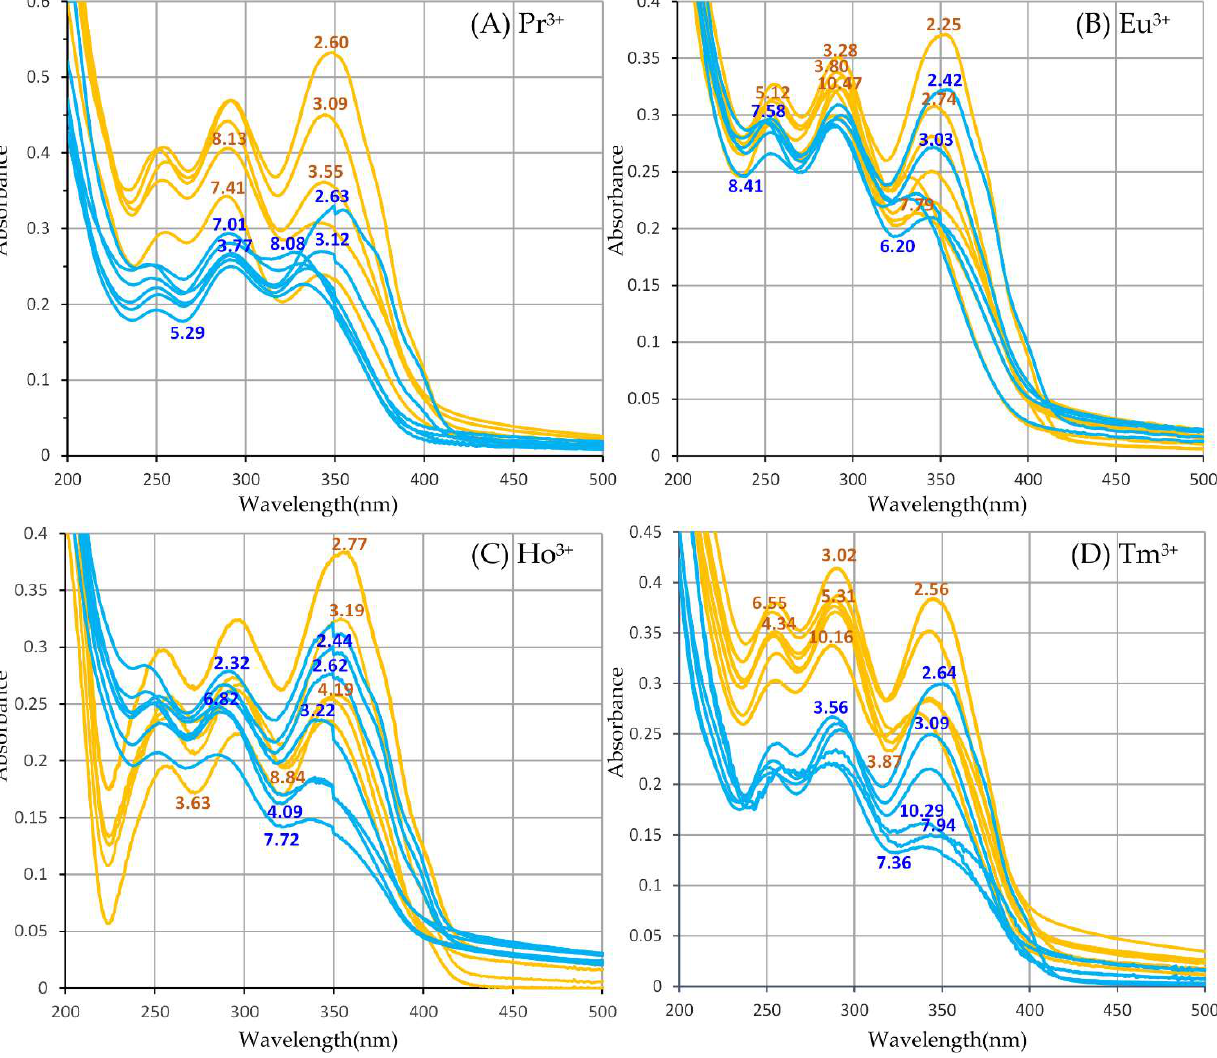
Figure 3. Raw UV-Vis spectra of ( A ) solutions of Pr 3+ and harzianic acid, ( B ) solutions of Eu 3+ and harzianic acid, ( C ) solutions of Ho 3+ and harzianic acid, and ( D ) solutions of Tm 3+ and harzianic acid of accurately known analytical composition and pH (= −log[H + ]). For each metal cation, absorption spectra define two groups differentiated by color: orange-colored spectra have been acquired on solutions with a nearly equal concentration of the ligand and metal; blue spectra have been acquired on solutions with a concentration of the ligand nearly twice that of the metal cation. Numerical labels on curves indicate the corresponding pH. Details on ligand and metal concentrations employed to collect the UV-Vis spectra are reported in Table 2. pH can be used to connect each spectrum to the corresponding solution in Table 2.